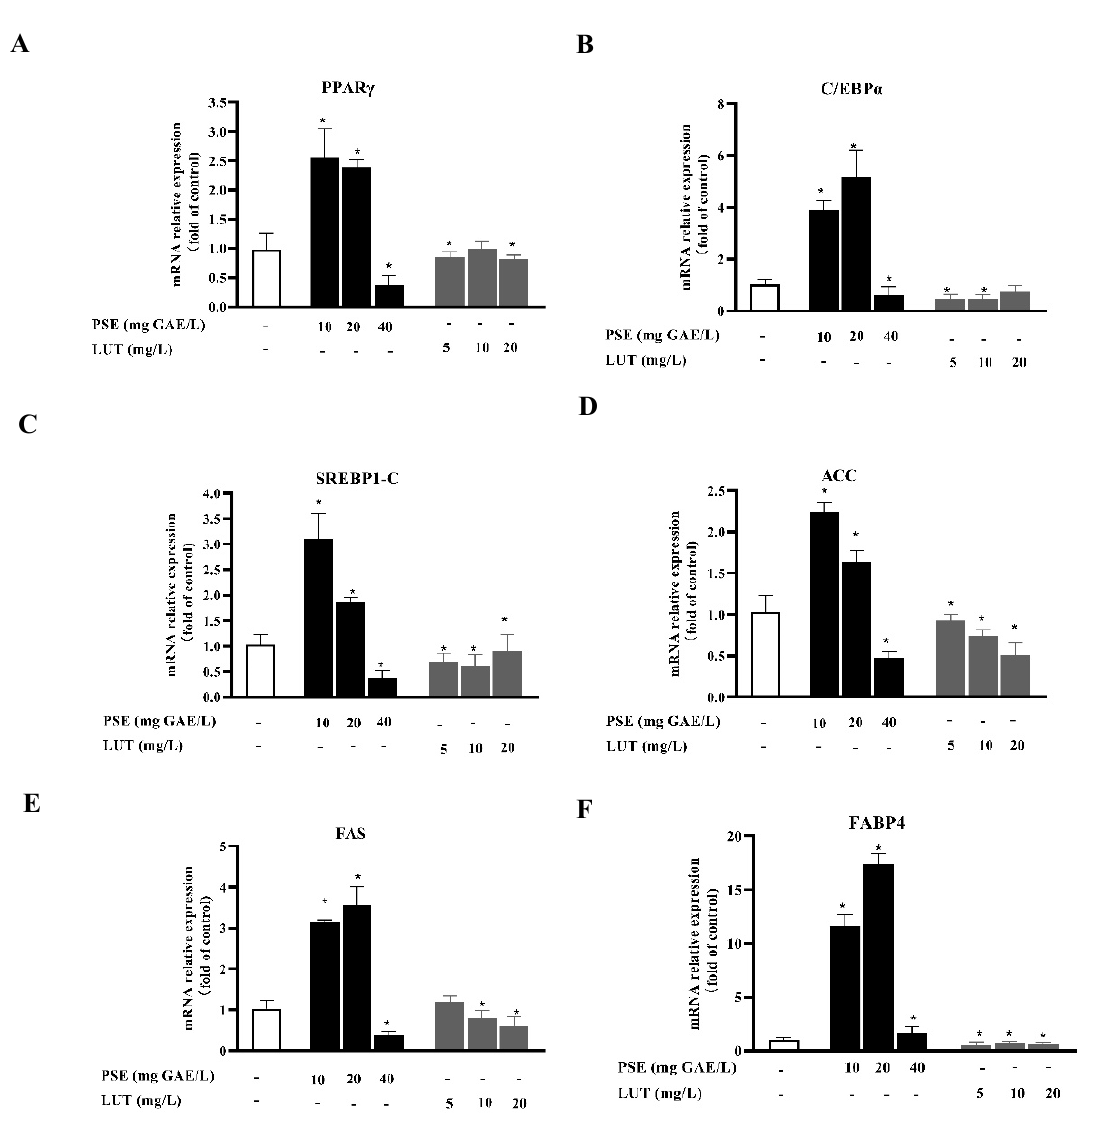
Figure 3. PSE and LUT modulated the expression of mRNA involved in adipogenesis in the 3T3-L1 adipocytes. The relative mRNA expressions of ( A ) PPAR γ , ( B ) C/EBP α , ( C ) SREBP1-C, ( D ) ACC, ( E ) FAS, and ( F ) FABP4. The data are presented as the mean ± S.D. from three independent experi- ments. * Significant differences are indicated by p < 0.05.